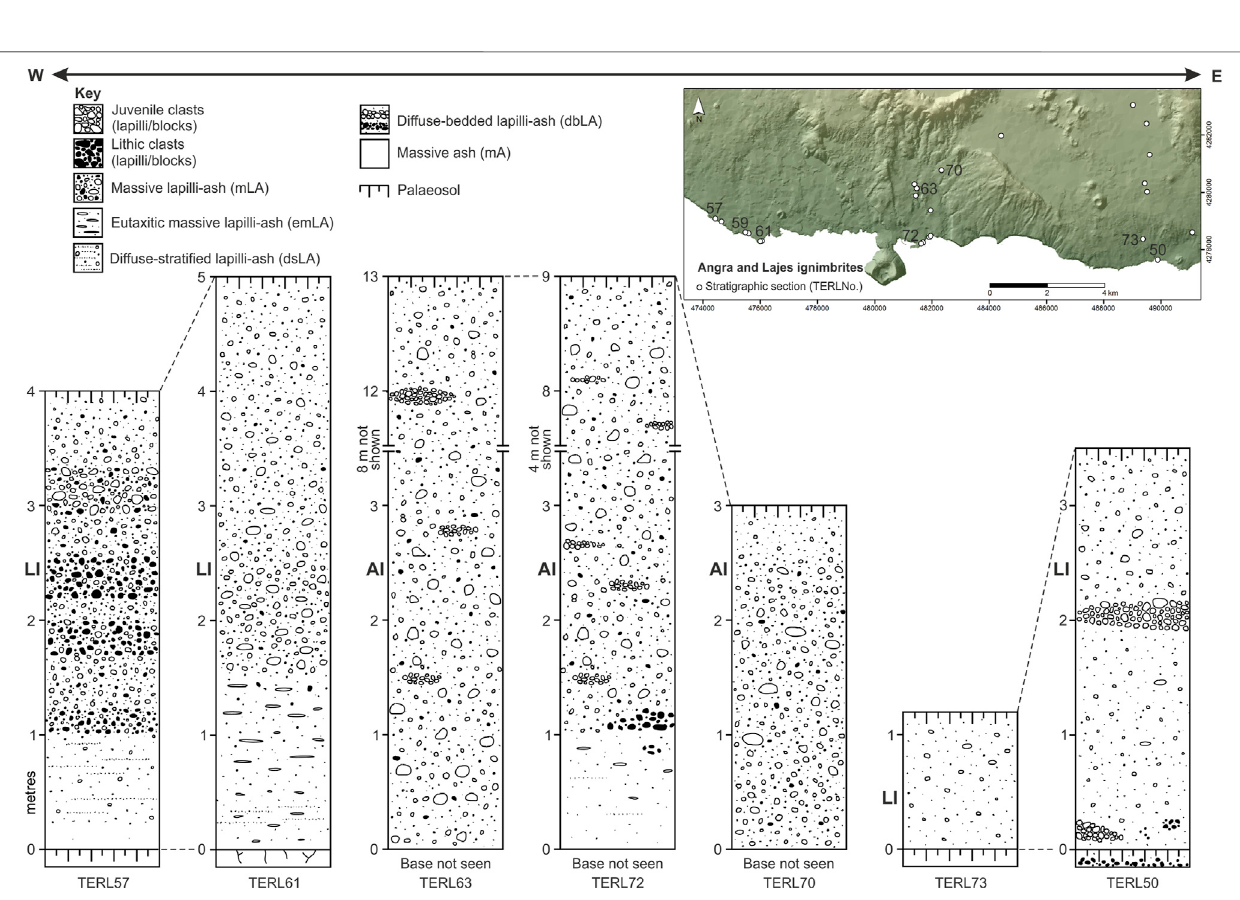
Frontiers in Earth Science |